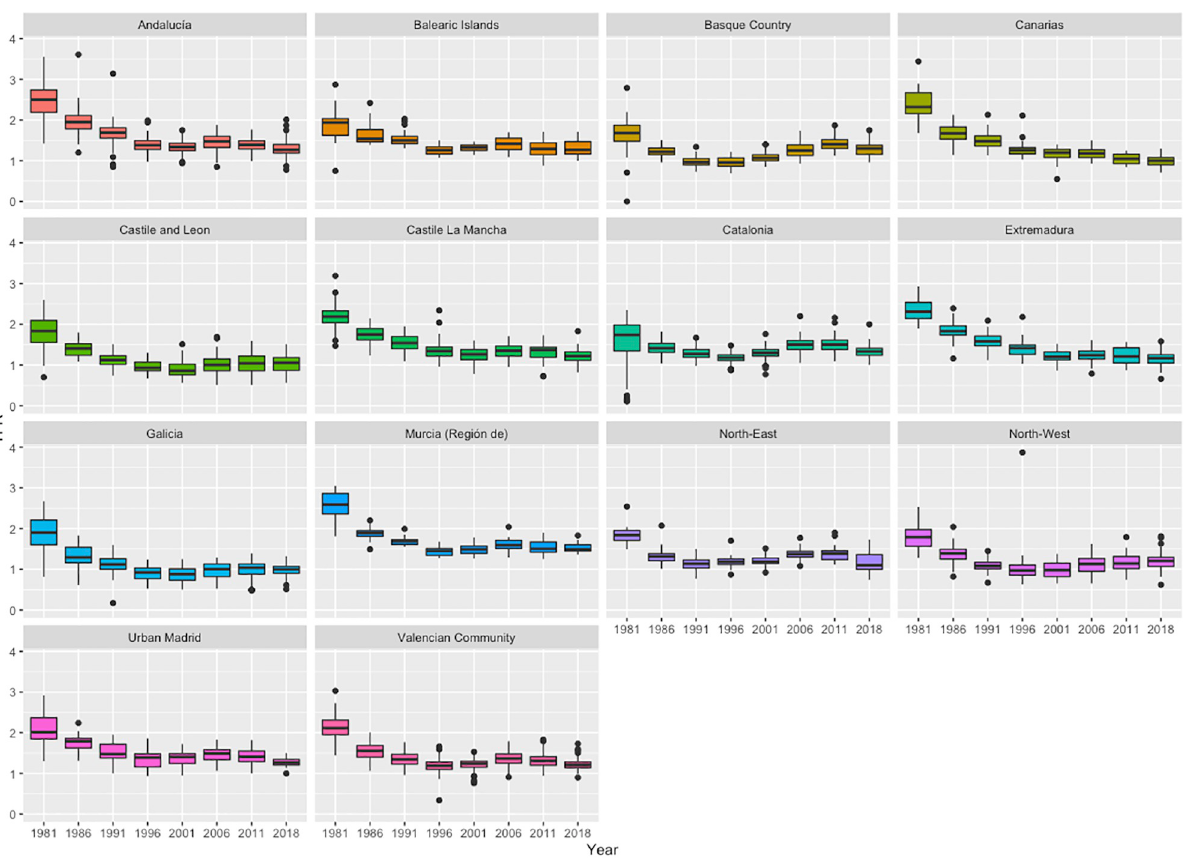
Fig 4. TFR evolution from 1981 to 2018 by region. Source: Data from the Spanish Statistical Office (INE).